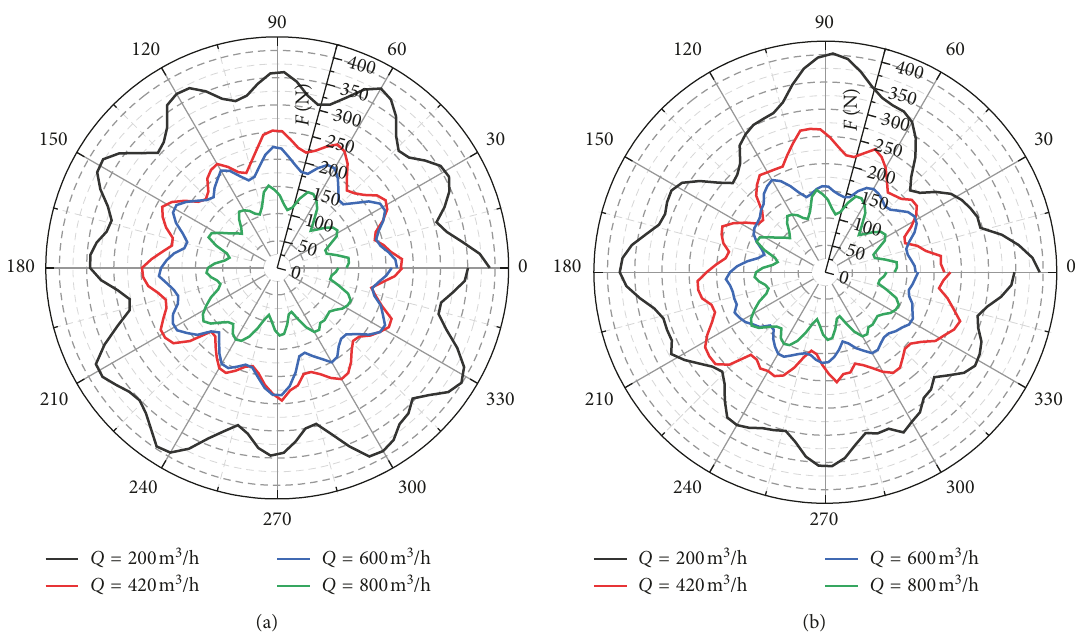
Figure 15: Polar coordinate diagrams of radial forces in the (a) primary impeller and (b) secondary